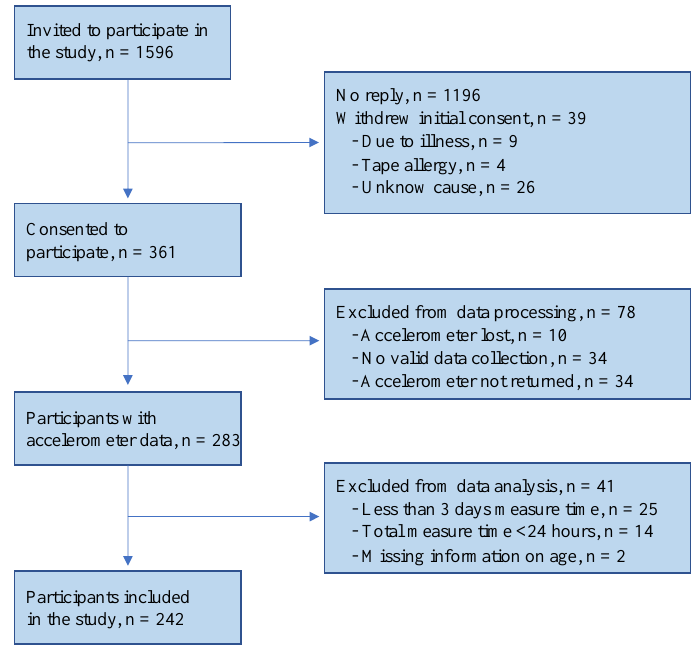
Figure 1. Flow chart on inclusion of